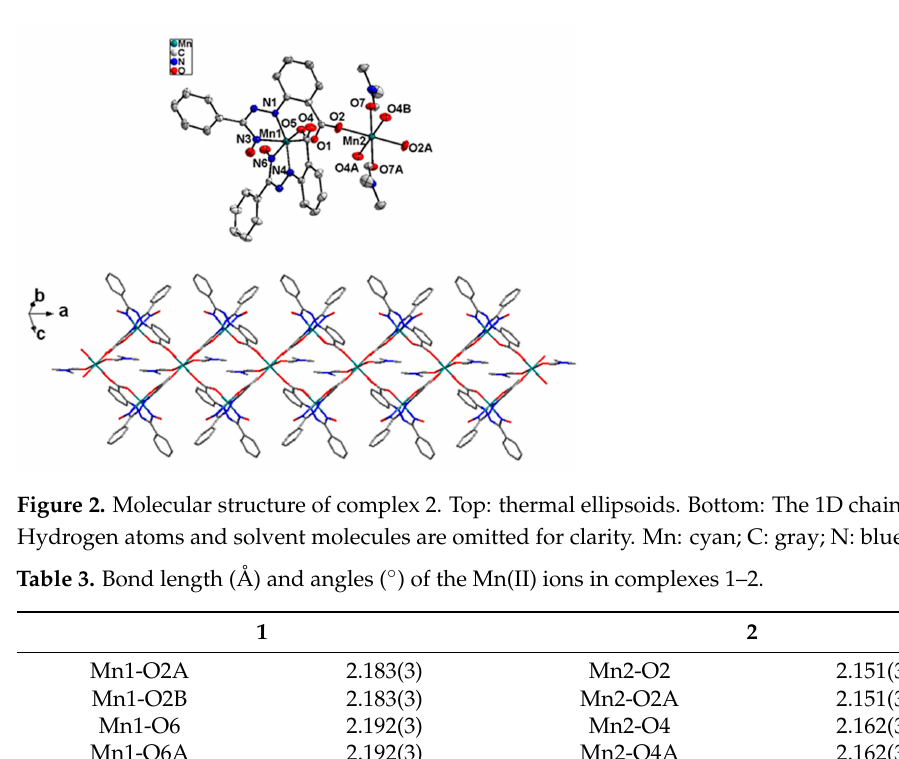
Figure 1. Molecular structure of complex 1. Top: thermal ellipsoids. Bottom: The 1D chain. Hydro- gen atoms and solvent molecules are omitted for clarity. Fe: dark yellow; Mn: cyan; C: gray; N: blue; O: red.